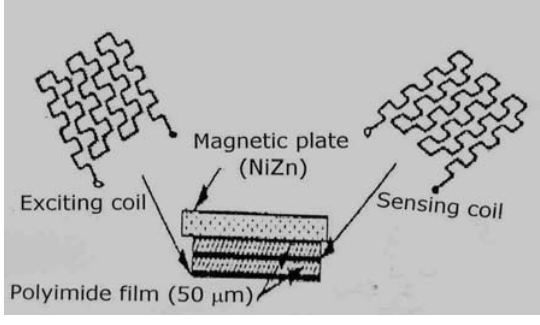
Figure 2. Structure of the